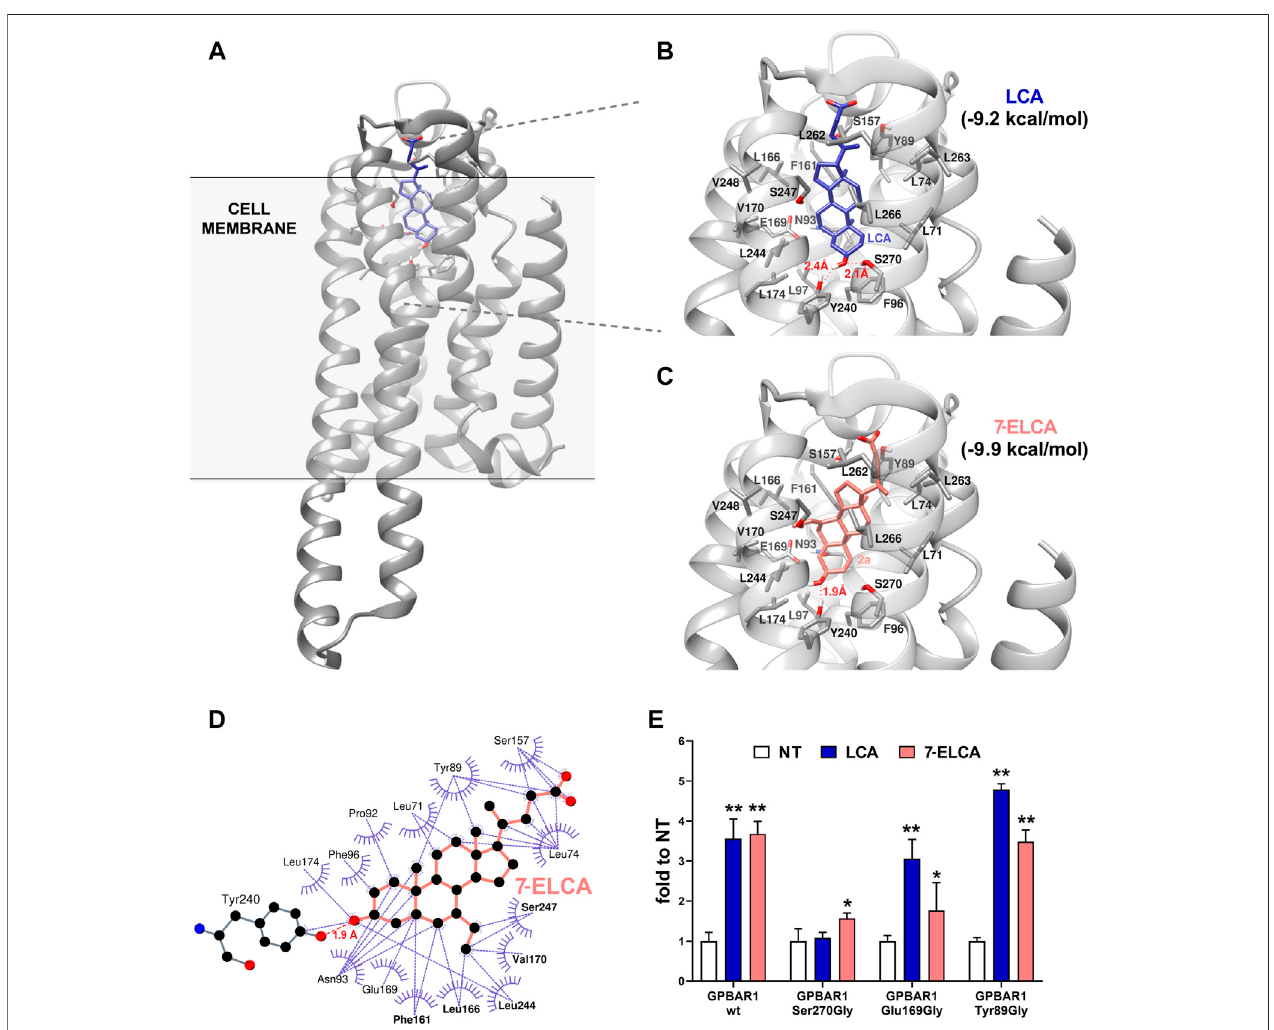
FIGURE 9 | Interactions of LCA and 7-ELCA in the ligand binding pocket of GPBAR1. (A) The position of the model ligand LCA is perpendicular to the cell membrane with A-ring facing the bottom of the LBD. Detailed presentation of LBD with LCA (B) and 7-ELCA (C) in the LBD of GPBAR1. Docking was carried out using AutoDock Vina 1.1.2. software. (D) A 2D representation of molecular interactions between 7-ELCA and GPBAR1 as generated in LigPlot+. The dashed line in red represents the hydrogen bond between C-3 substituent of 7-ELCA and Tyr240. Dashed lines in purple represent hydrophobic interactions. Amino acid residues forming the hydrophobic pocket are presented in bold. (E) HepG2 cells were co-transfected with CRE-luc together with the wild type ( wt ) GPBAR1 or its mutated variantsSer270Gly,Glu169GlyorTyr89Glyasindicated.Luciferaseactivitywasnormalizedtothe Renilla luciferaseasaninternalcontrol.Dataareexpressedasmeans ± SD from three independent determinations performed in triplicates. ** p < 0.01, *** p < 0.001 vs. NT.